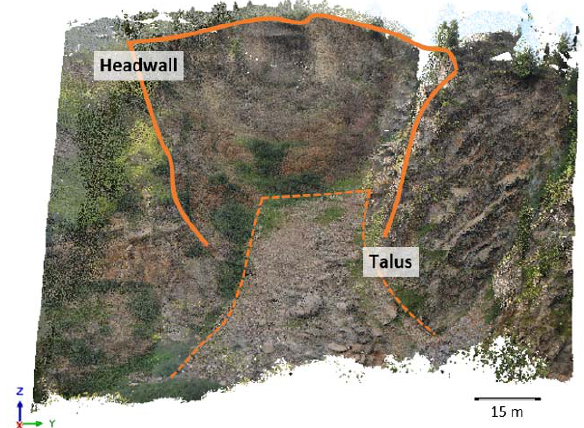
Figure 4. TLS point cloud of Zirbenwald rockfall acquired in July 2015, coloured by RGB. Headwall and talus are schematically delineated.